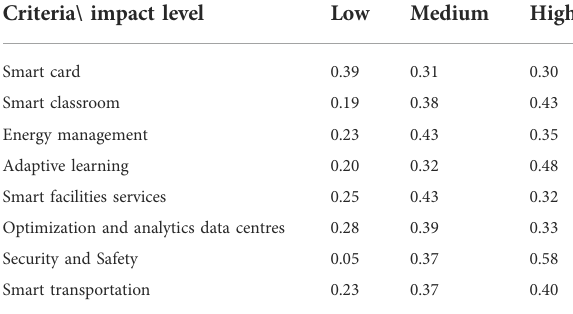
TABLE 7 Total probability